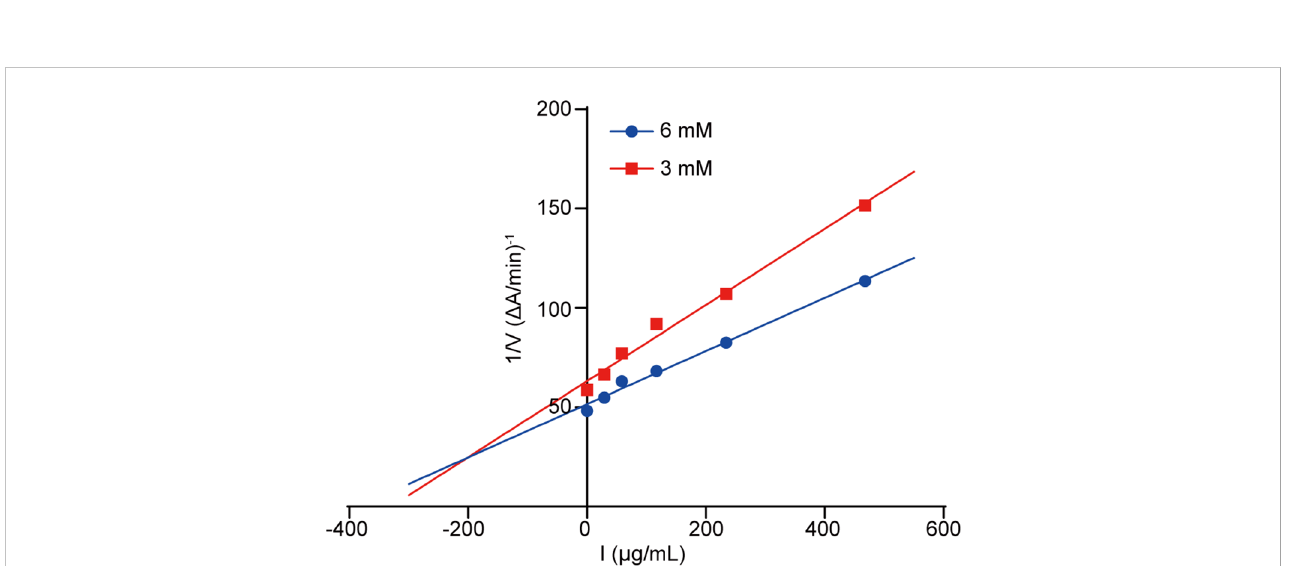
FIGURE 6 Dixon diagram. Dixon plot showing the inhibitory activities of compound 5 against AChE in the presence of different concentrations of substrate. Red and blue lines indicate concentrations of 3 and 6 mM, respectively.